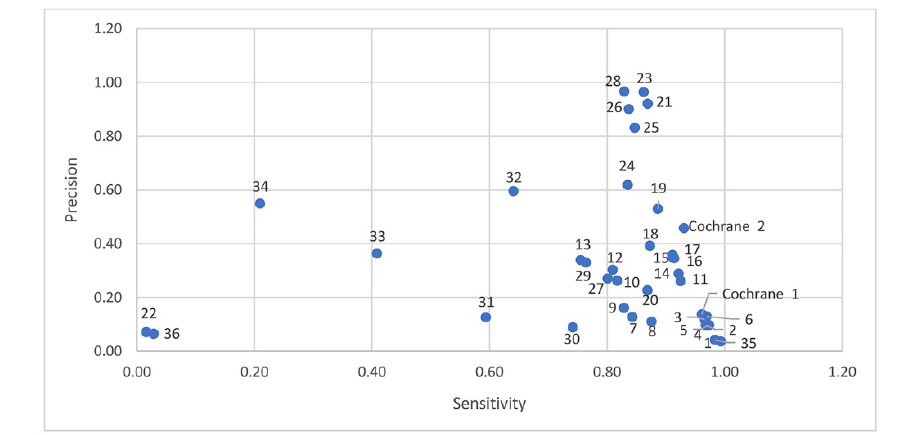
Figure 1 Sensitivity and relative precision of 38 randomized controlled trial (RCT) filters